Question: Write the caption for this figure.
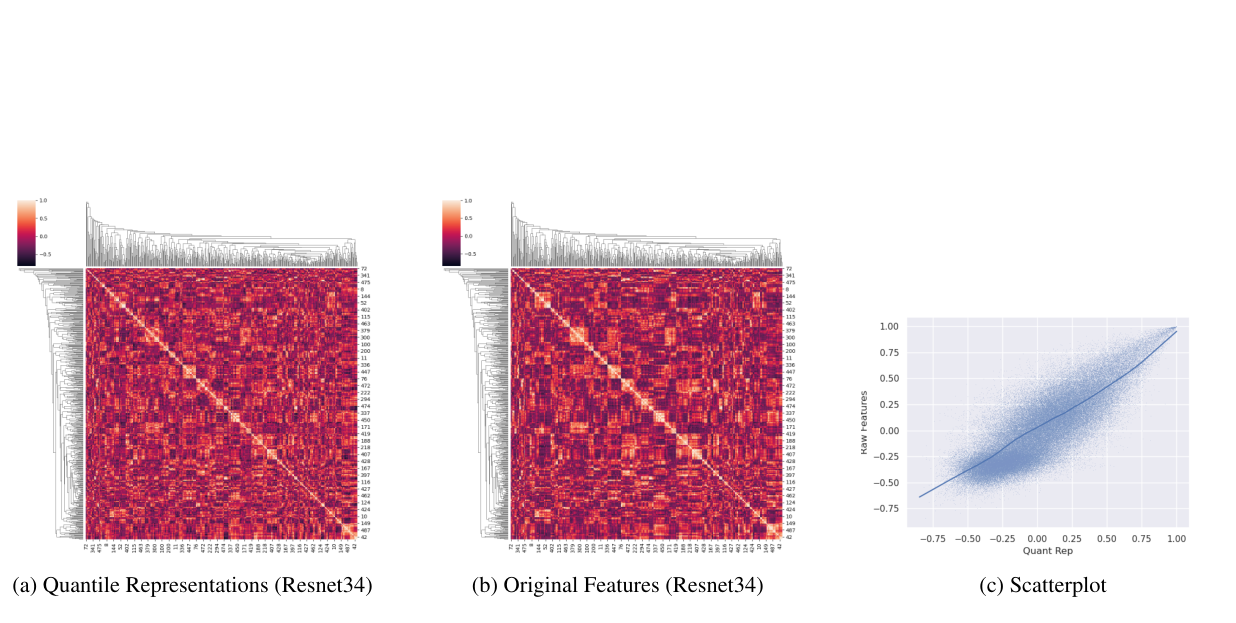
Answer: Do quantile representations capture the relevant information for classification? (a) Cross-correlations obtained using Quantile representations for Resnet34 on CIFAR10 (b) Cross-correlations obtained using train features for Resnet34 on CIFAR10. (c) Scatterplot with best fit line (using Locally Weighted Scatterplot Smoothing[Cleveland, 1979]) of the cross-correlation of features. Observe that as the correlation becomes important (i.e close to −1 or 1) quantile representations are more consistent with raw features.